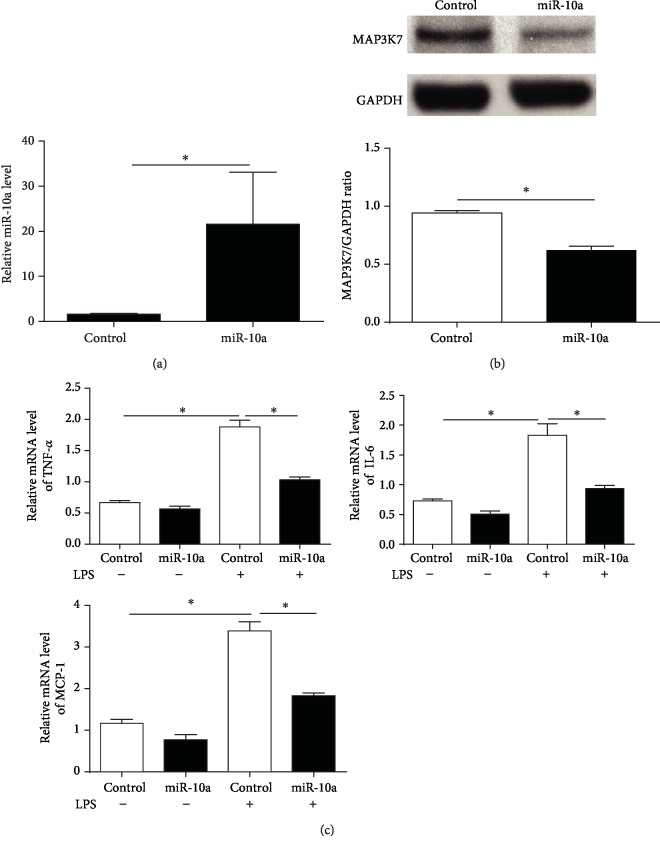
Effect of miR-10a overexpression on LPS-induced inflammatory cytokine production in monocytes. THP-1 monocytes were transduced with lentiviral miR-10a or miR-control. (a) Four days after the transduction, miR-10a levels in THP-1 cells were determined via qRT-PCR. (b) MAP3K7 expression in transduced THP-1 cells was determined via Western blot analysis. (c) The transduced cells were treated with or without LPS (100 ng/ml) for 24 h. Levels of IL-6, TNF-α, and MCP-1 in treated cells were assayed via qRT-PCR. Data are presented as mean ± SEM, n = 4. ∗p < 0.05.